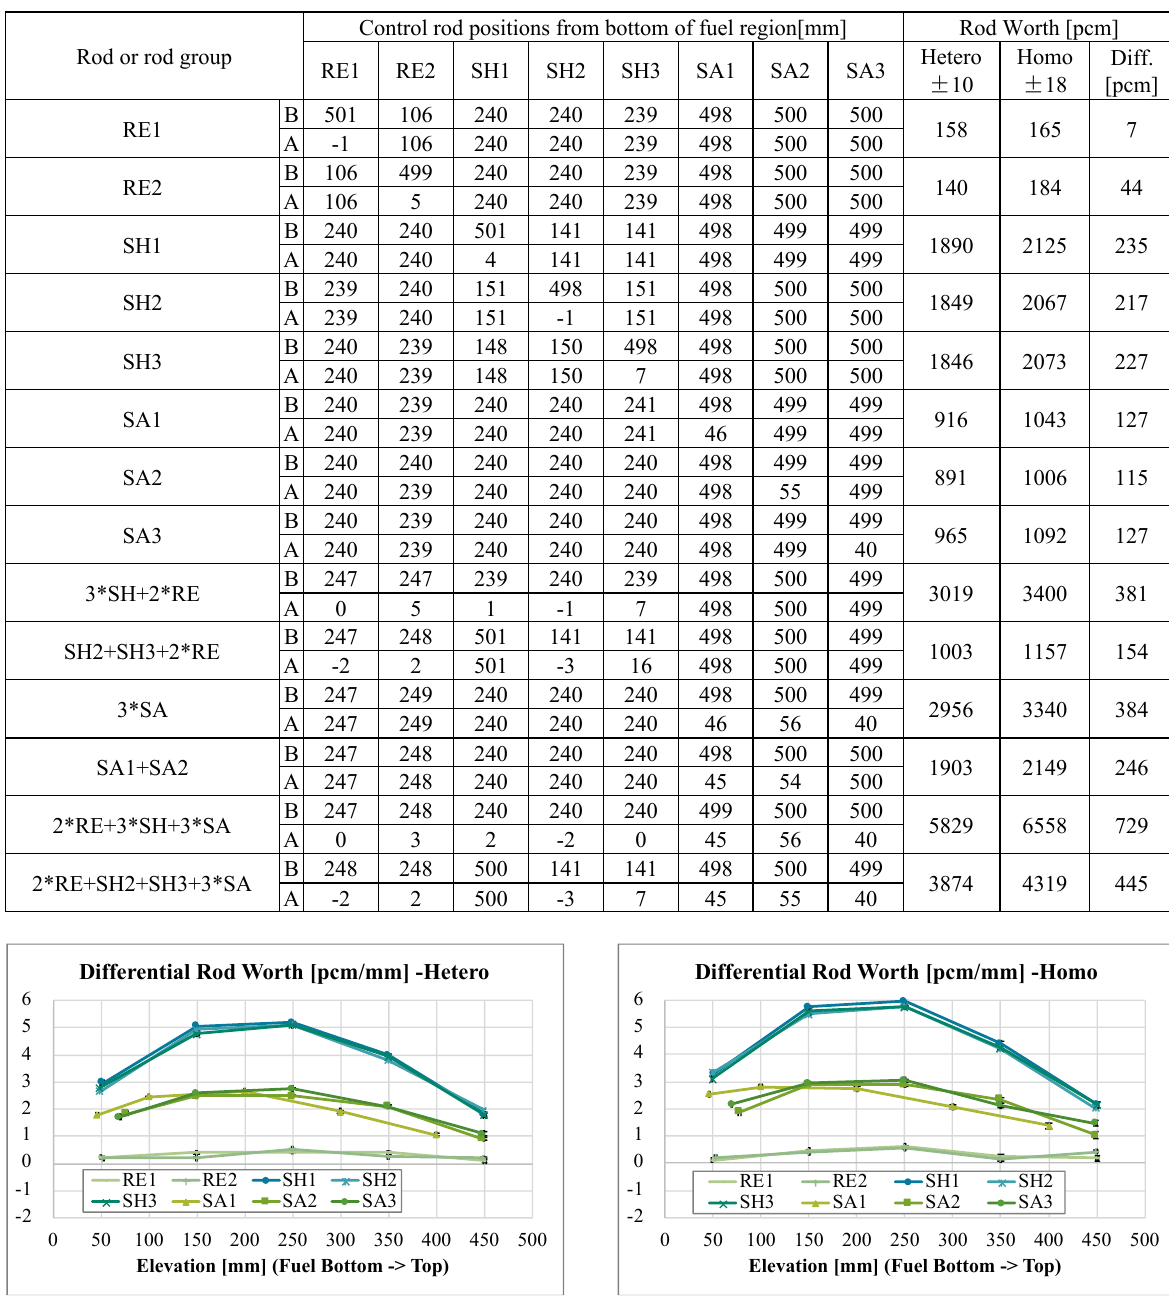
Figure 4. Differential Rod Worth